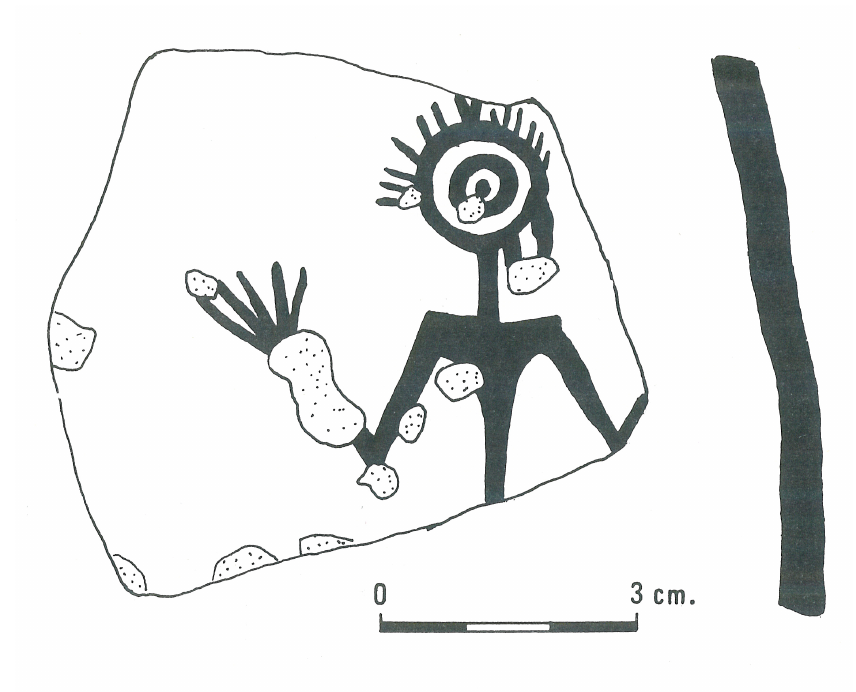
Figure 7 Painted depiction of human figures in the QPW. From the Temple of Hathor, Timna. After Rothenberg 1988, Fig. 7:2. With kind permission from the Institute for Archaeo- Metallurgical Studies, University College